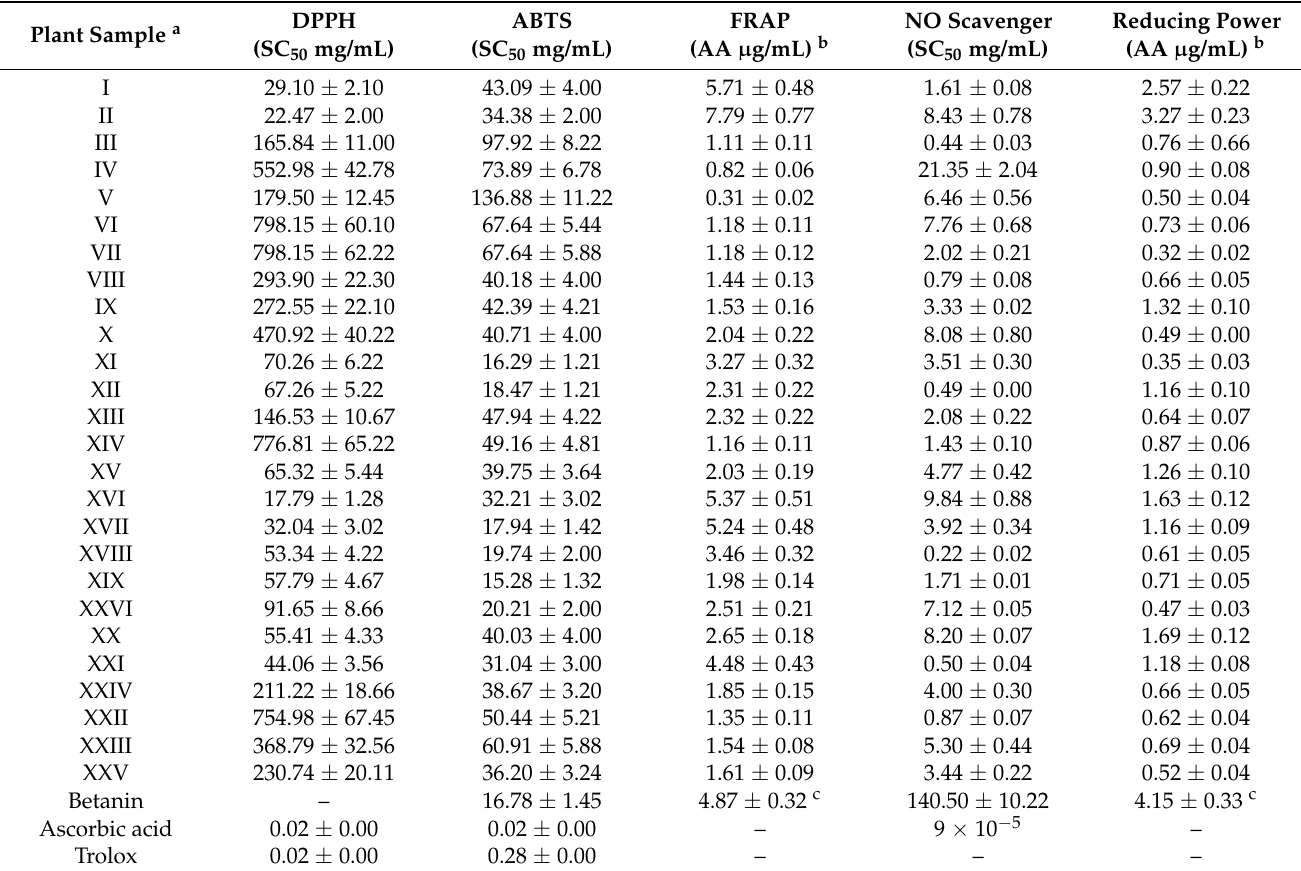
Table 5. Antioxidant activity of Epiphyllum , Hylocereus , and Opuntia fresh fruit water extracts. Plant Sample a